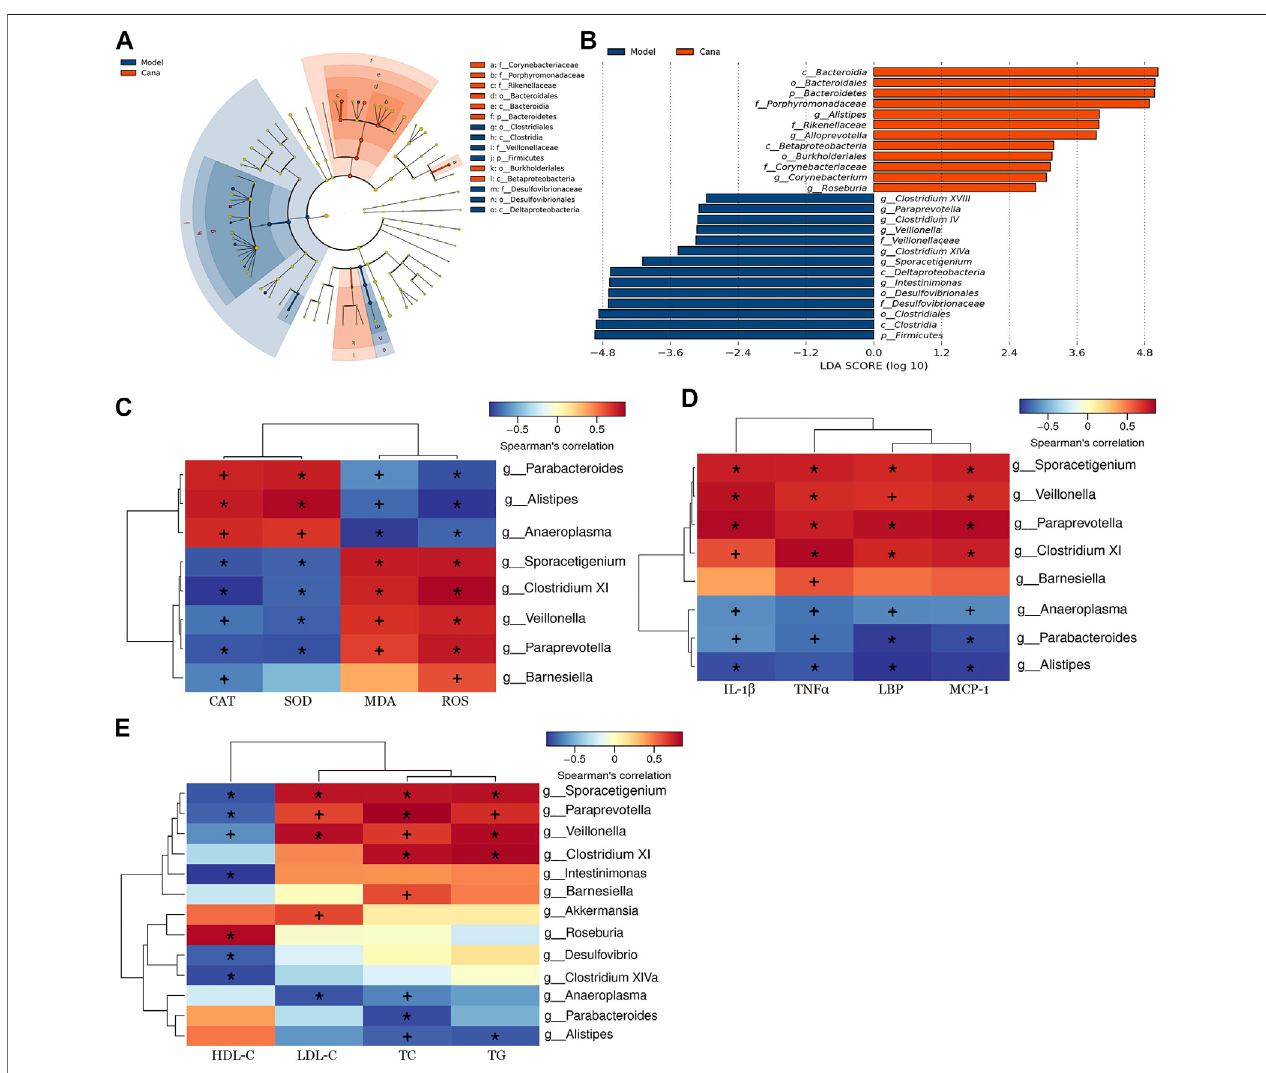
FIGURE6| LEfSeandSpearman ’ scorrelationanalyses.LEfSeanalyzedthemostdifferentialtaxonsbetweenthemodelgroupandCanatreatmentgroup (A) .Taxa increased after Cana treatment (orange) showed a positive score, while model group-enriched taxa (dark blue) showed a negative LDA score (B) . Heatmap of Spearman ’ s correlations analysis between bacteria and physiological indices (C – E) . The abscissa represents the physiological indices, and the ordinate represents the bacterialspecies.Theshadeofcolordirectlyindicatesthecorrelationbetweenphysiologicalindicesandbacteria.Thecorrelationbetweenbiomarkerandmicrobial species was visualized by color depth: the darker the color, the more relevant itis. * p < 0.01, + p < 0.05. Three mice in each group were randomly selected for analyses.